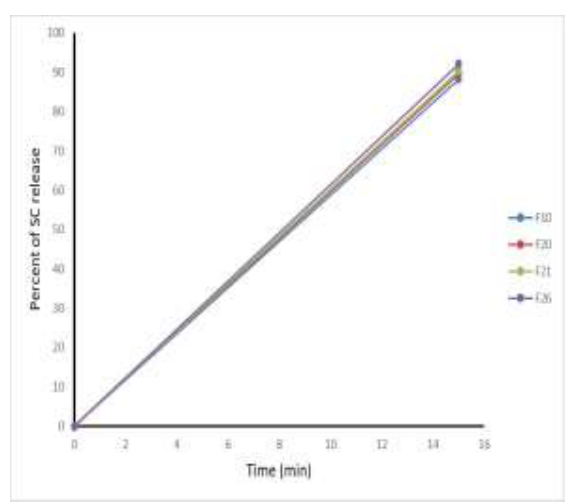
Figure 3. The percent release of SC with time in SFF (pH 6.8) at